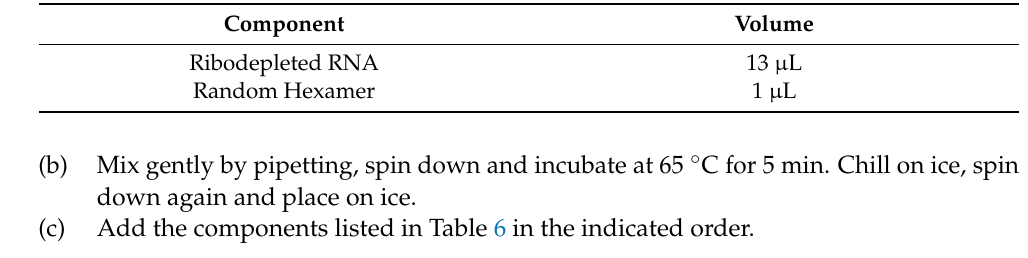
Table 5. Random hexamer binding reaction mix.